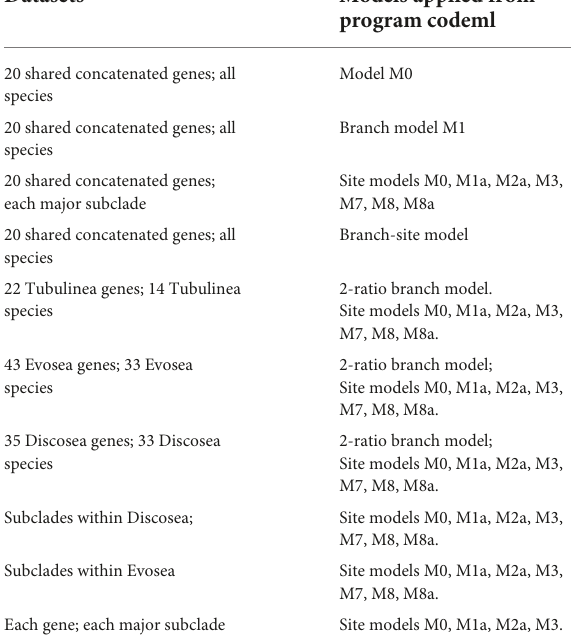
TABLE 1 A summarization of the datasets and the corresponding models